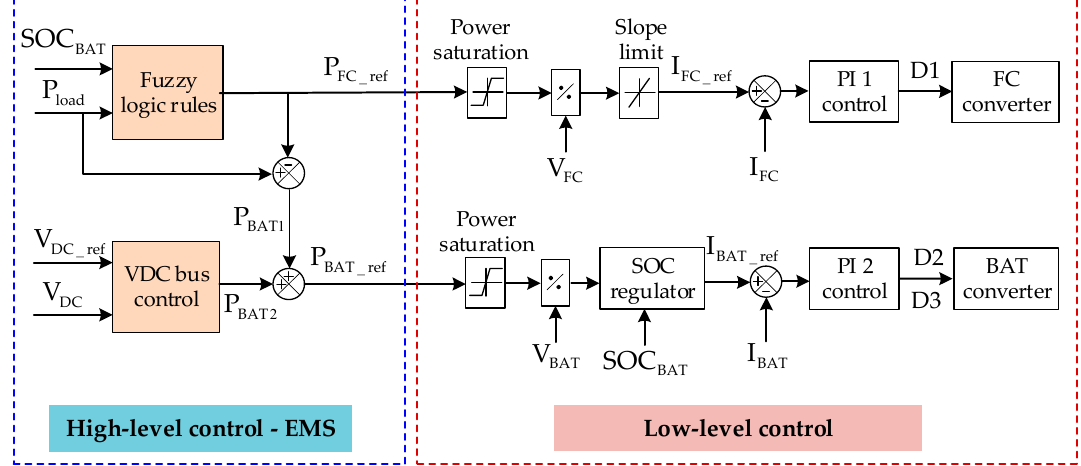
Figure 6. Proposed energy control strategy.